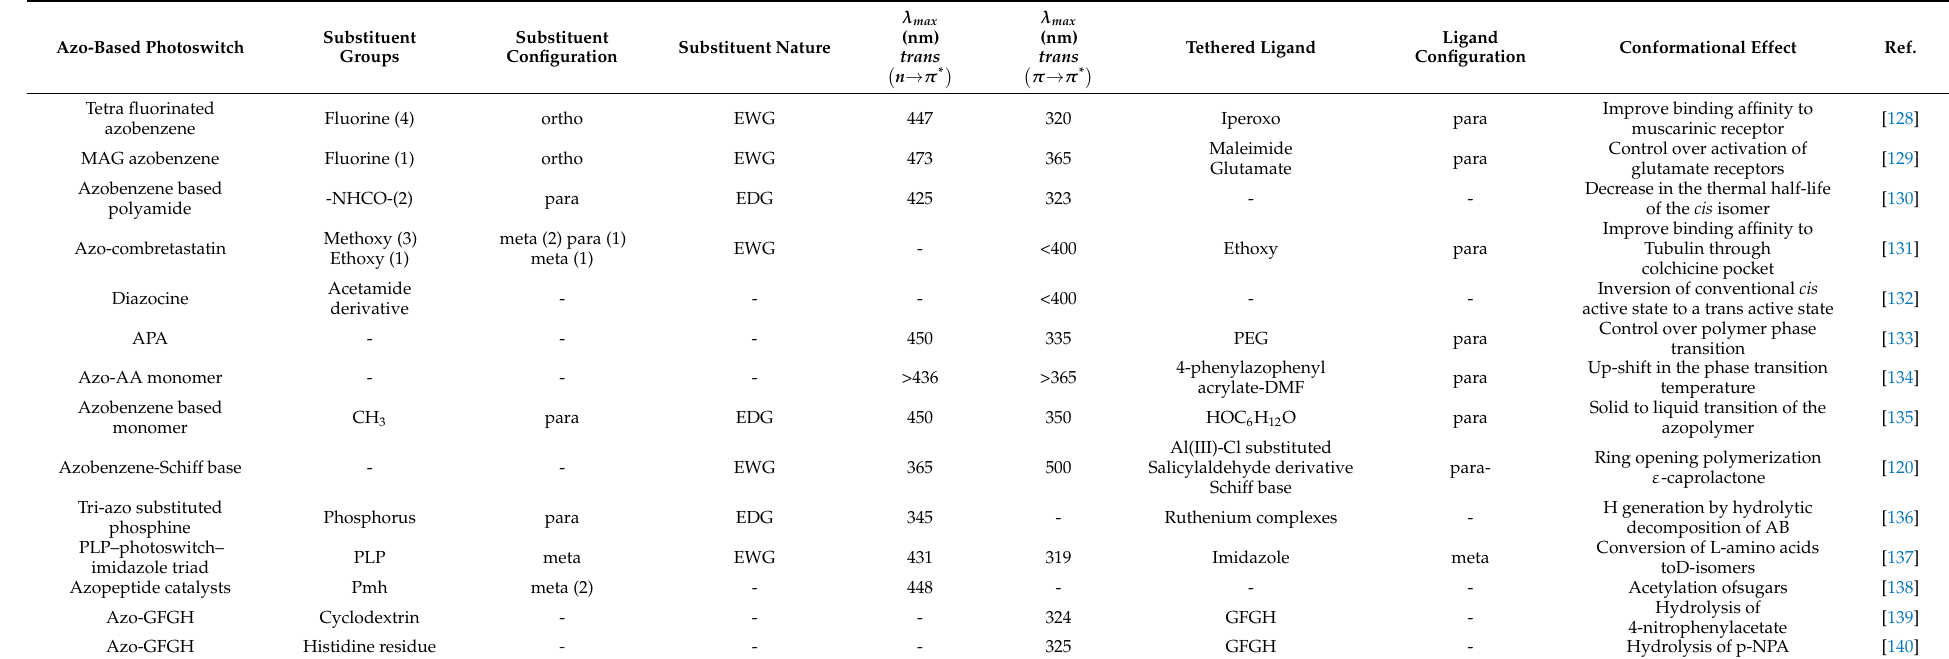
Table 2. Some azobenzene systems with photoswitchable